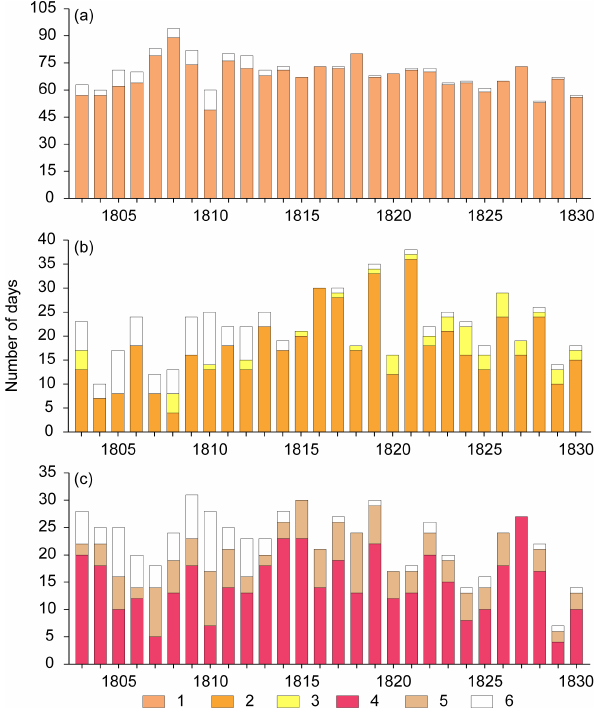
Figure 8. Fluctuations in the annual number of days with se- lected phenomena at Buchlovice during 1803–1830 derived from the weather diary kept by Šimon Hausner: (a) strong wind (1); (b) fog (2 – fog, 3 – foggy); (c) thunderstorm (4 – at Buchlovice, 5 – distant thunderstorm) (6 – missing